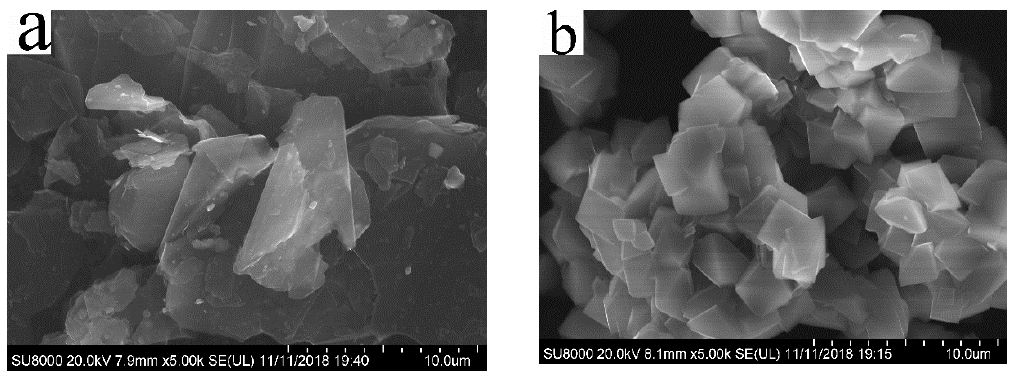
Figure 6. SEM graphite micrographs in bacterial growth after coculture for 5 days: ( a ) before co-culture; ( b ) after co-culture (other conditions: 1.6 pH, 0.5 g/L graphite, 45 °C, 170 rpm).